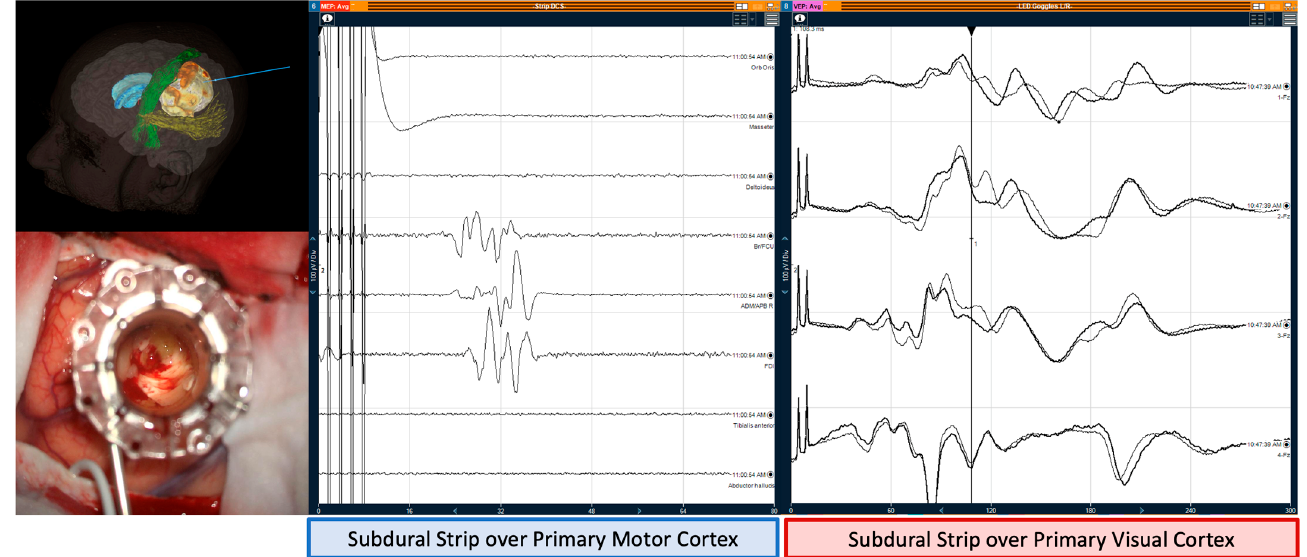
Figure 2. Example of a minimally invasive parafascicular approach (MIPS) for tumour. The recordings from the subdural strip over primary motor cortex ( left ) show positive motor evoked responses from the right brachioradialis/flexor carpi ulnaris, abductor digiti minimi/ abductor pollicis brevis, and first dorsal interossei at 100 µ V amplitude and a latency of ~30 ms, from direct cortical stimulation using the strip electrode with 5 anodal pulses, 500 µ s pulse width, at 8 mA, with software filters of 30–2000 Hz. The recordings from the subdural strip over primary visual cortex ( right ) show visual evoked potentials recorded using the direct cortically placed strip electrode over the calcarine fissure, from simultaneous stimulation of the bilateral eyes through LED goggles placed over the eyelids at 10,000 lx intensity and 3.1 Hz, using software filters of 10–500 Hz. All four contacts of this strip electrode were referenced to the Fz scalp electrode placed on the left mastoid. The VEPs are observed at 100 µ V amplitude, latencies of each peak are seen at N1 ~50 ms, P2 ~60 ms, N3 ~68 ms, P2 ~100 ms, N3 at ~115, and P3 at ~135 ms.